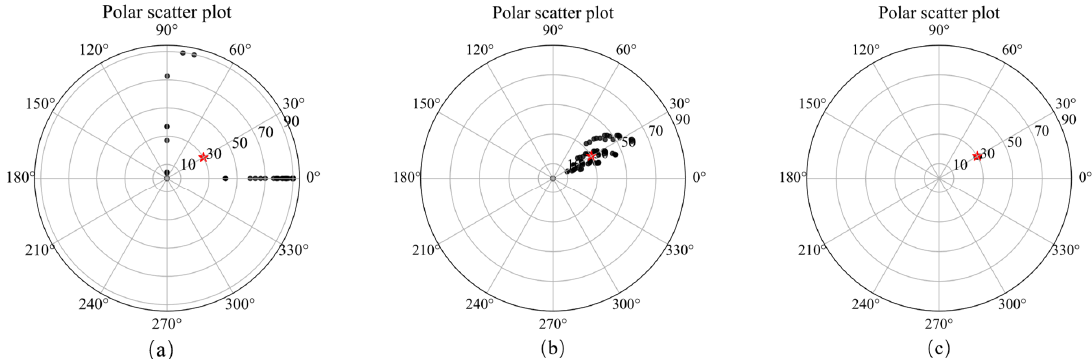
Figure 8. Polar scatter plots showing inverted magnetic inclination (radial) and declination (axial) of method 1 ( a ), method 2 ( b ) and method 3 ( c ) and the ground truth (red star).